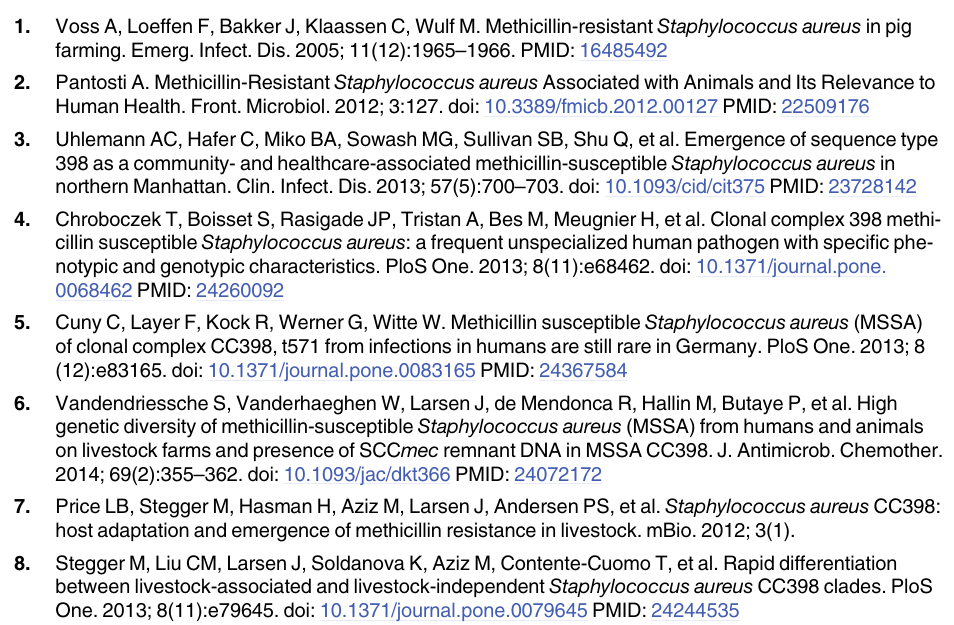
S1 Table. Details of primers, thermal cycling conditions and positive control strains used in the present